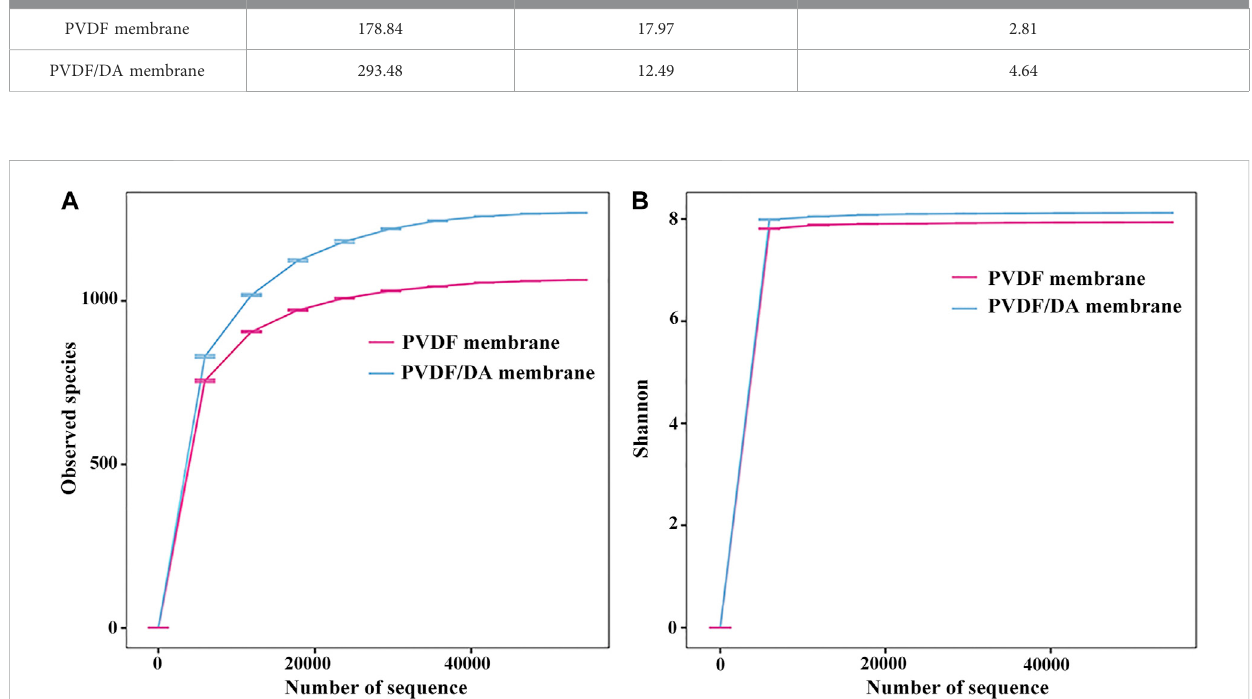
FIGURE 10 Index dilution curve: (A) observed species and (B) Shannon